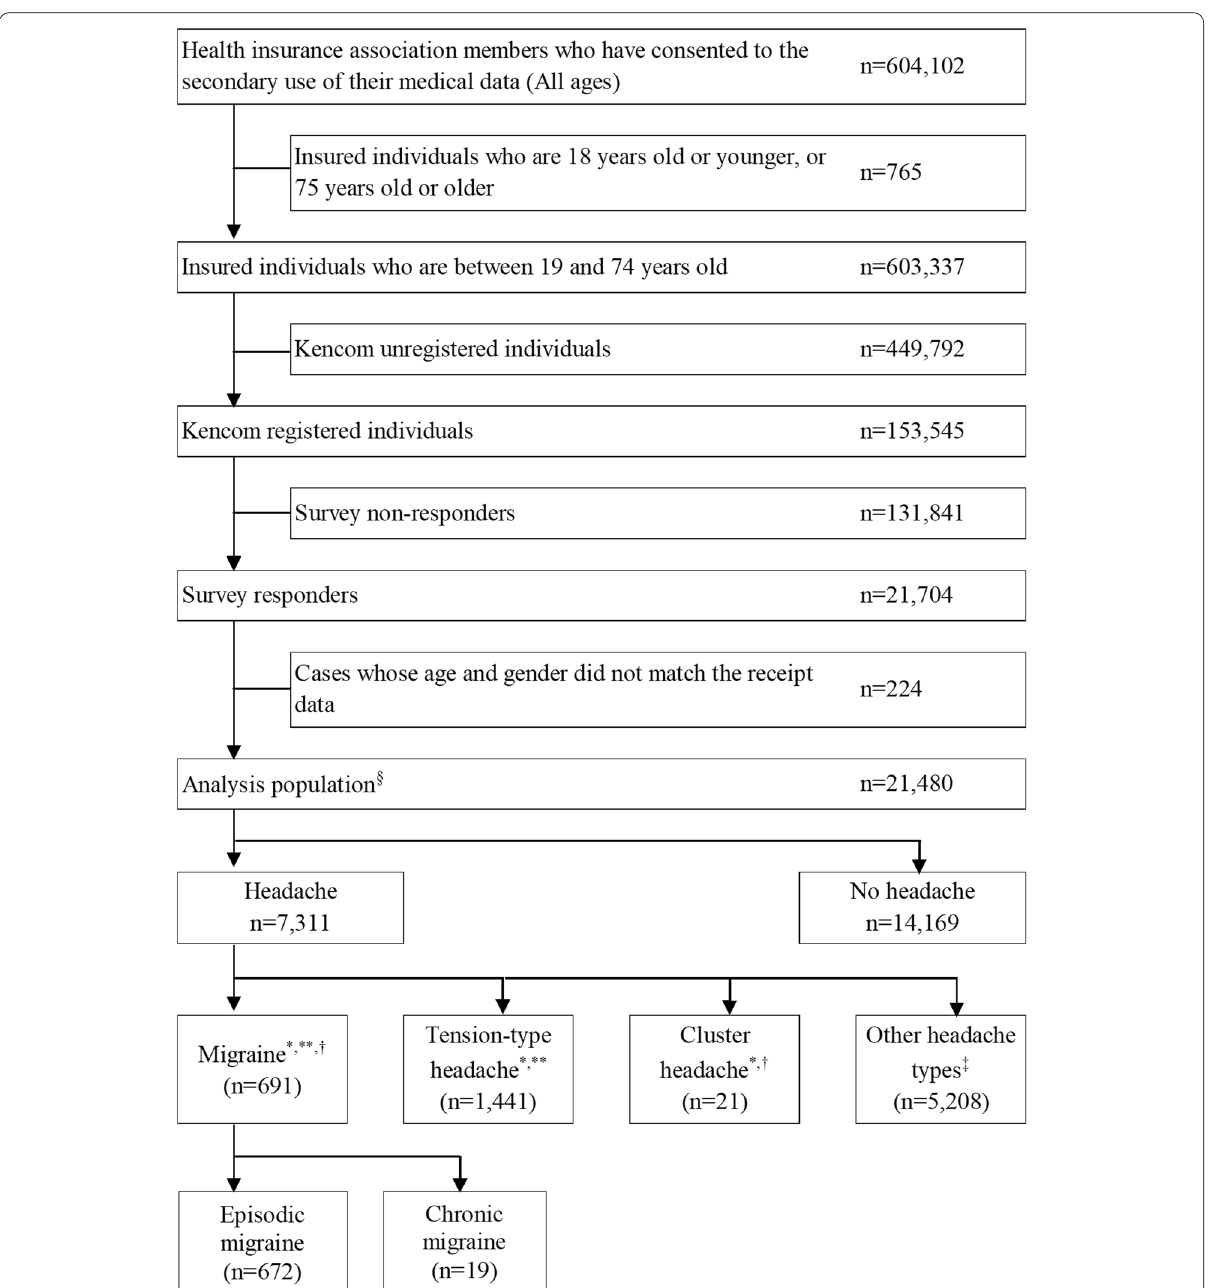
Fig. 2 Patient disposition. * Each group except the group of other headache types included individuals classified as probable migraine, probable tension-type headache, or probable cluster headache, respectively. ** There were 42 individuals who were classified into both migraine and tension-type headache. † There were 8 individuals who were classified into both migraine and cluster headache. ‡ Post-hoc analysis of the “other headache types” showed 261 people who had two or more matches with ID Migraine [18] and 286 people who had two or more matches with the 4-item simple migraine screener [19]. § Among the analysis population ( n 21,480), 7.1% of the individuals included in the analysis set were = dependents of individuals directly insured by the health insurance